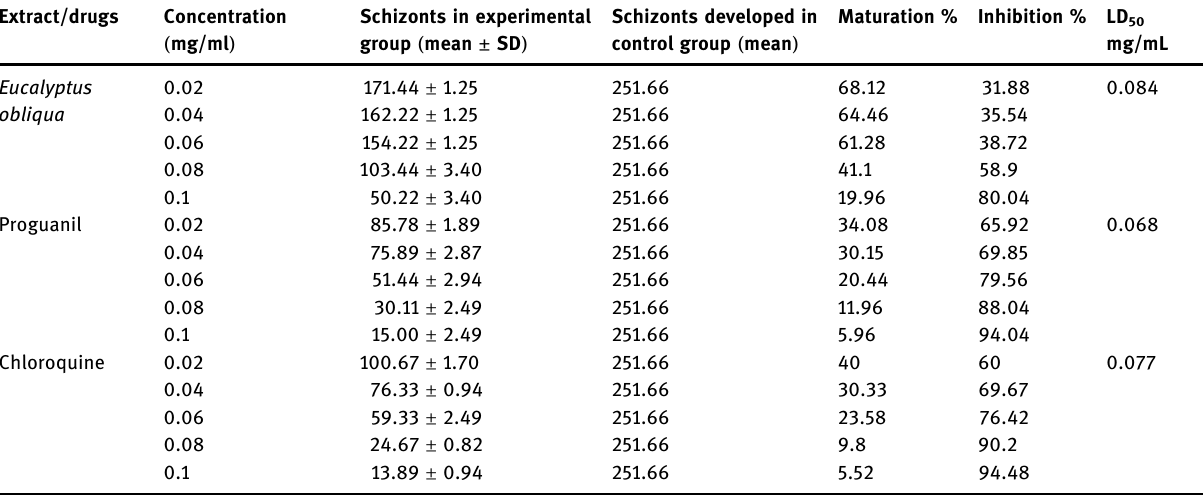
Table 1: The in vitro antiplasmodial activity of Eucalyptus obliqua methanolic crude extract